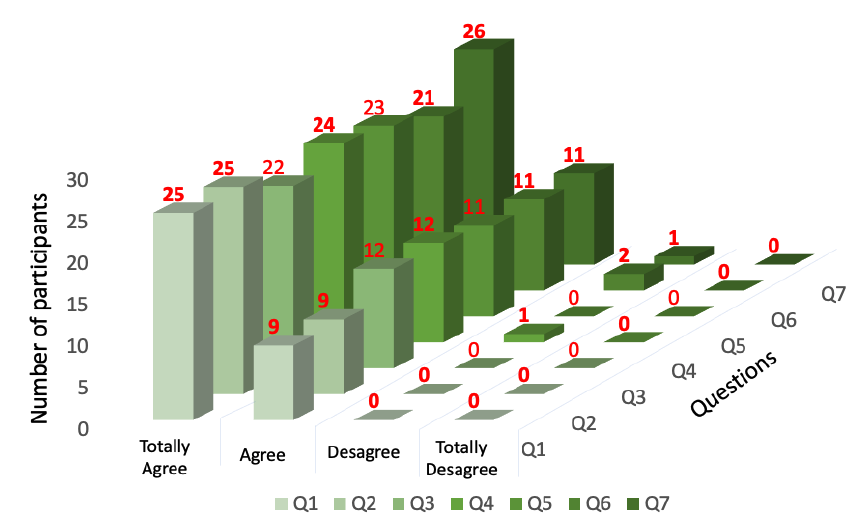
Figure 11. AR-electronics app’s general evaluation.